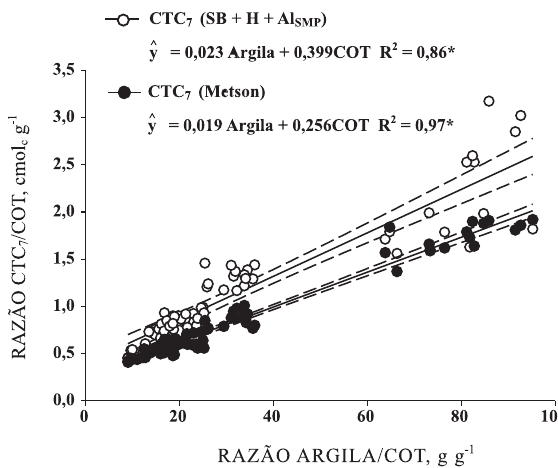
Figura 4. Contribuição da fração de argila e de carbono orgânico total (COT) à capacidade de troca de cátions potencial obtidas pelos métodos preconizados pela CQFSRS/SC (2004) e pela (Afnor, 1996). As linhas pontilhadas são os intervalos de confiança (p <